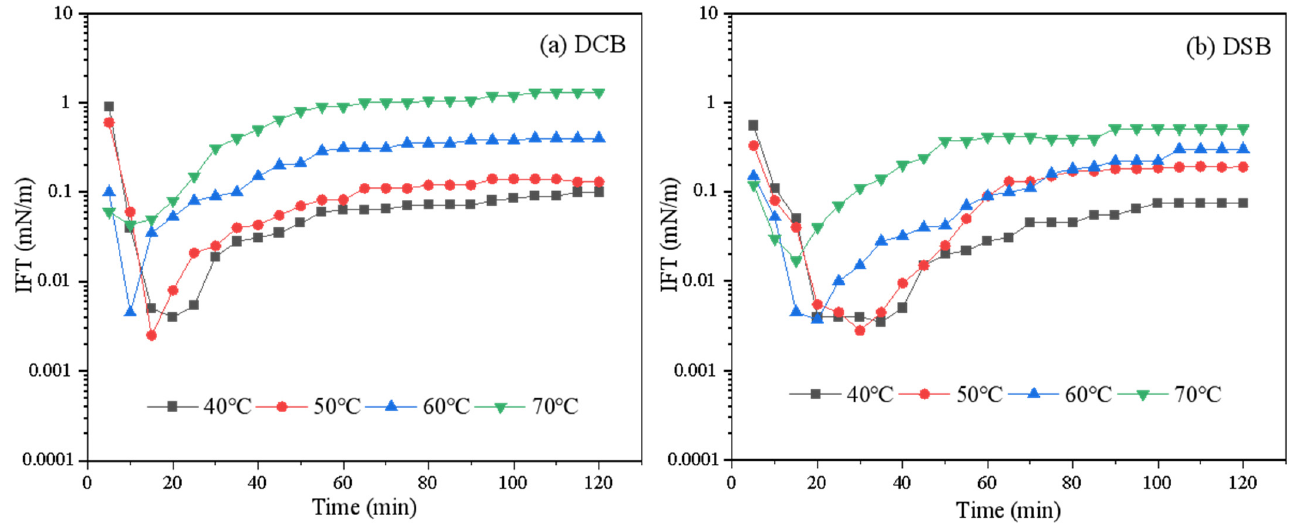
Figure 4. Effects of temperature on IFT between the optimum concentrations of surfactants and Xinjiang crude oil for DCB ( a ) and DSB ( b ).